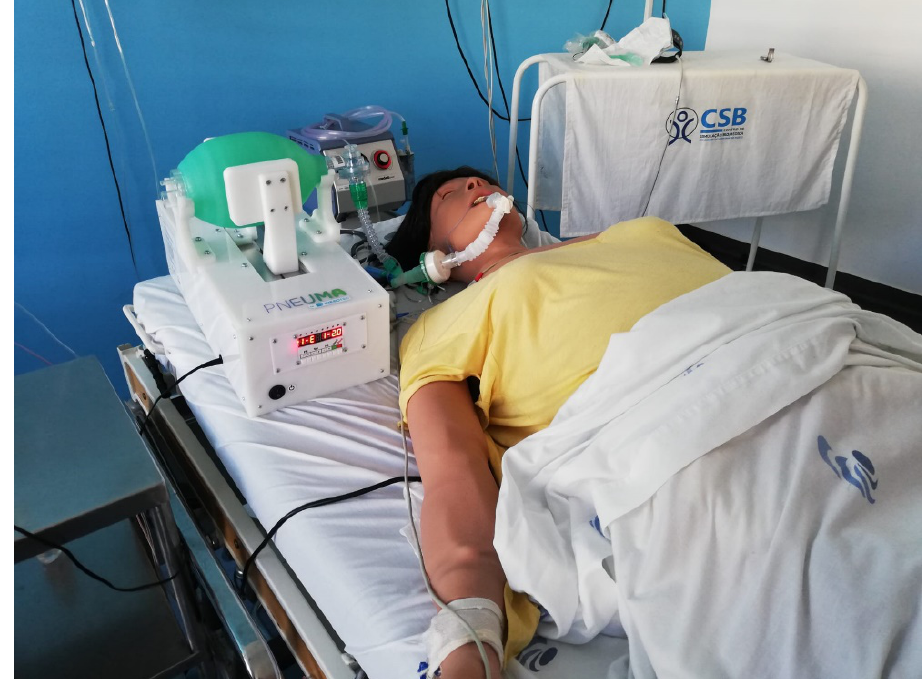
Fig. 3. Pneuma being tested coupled to a full-body patient simulator at the Biomedical